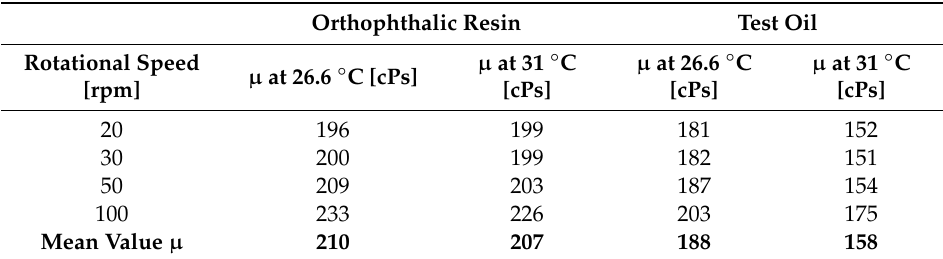
Table 3. Resin and test oil viscosity as measured in experimental tests.